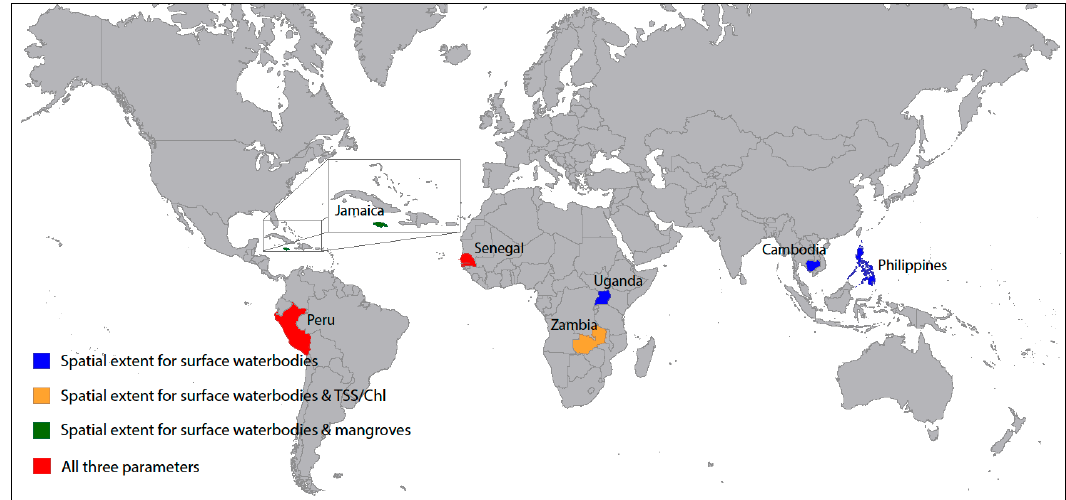
Figure 1. Map of the countries in this study, indicating the SDG Indicator 6.6.1 components and categories investigated for each